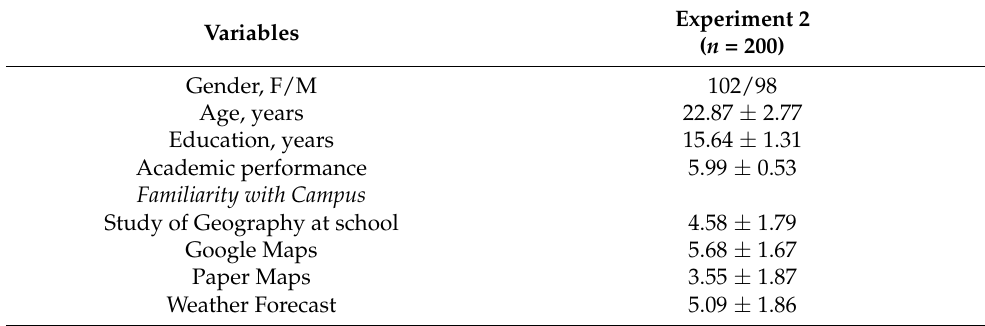
Table 4. Descriptive statistics of the sample. Means ± standard deviations for interval and frequencies for nominal variables were reported. χ 2 for frequencies were